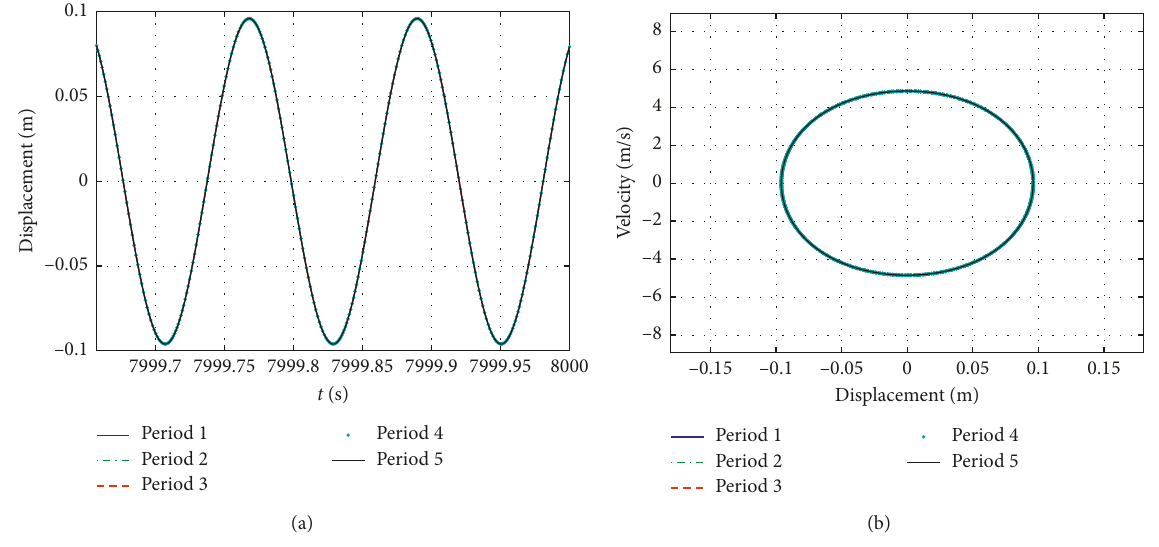
Figure 15: Five periodic oscillators’ (a) displacement time history curves and (b) phase diagrams (effective zero